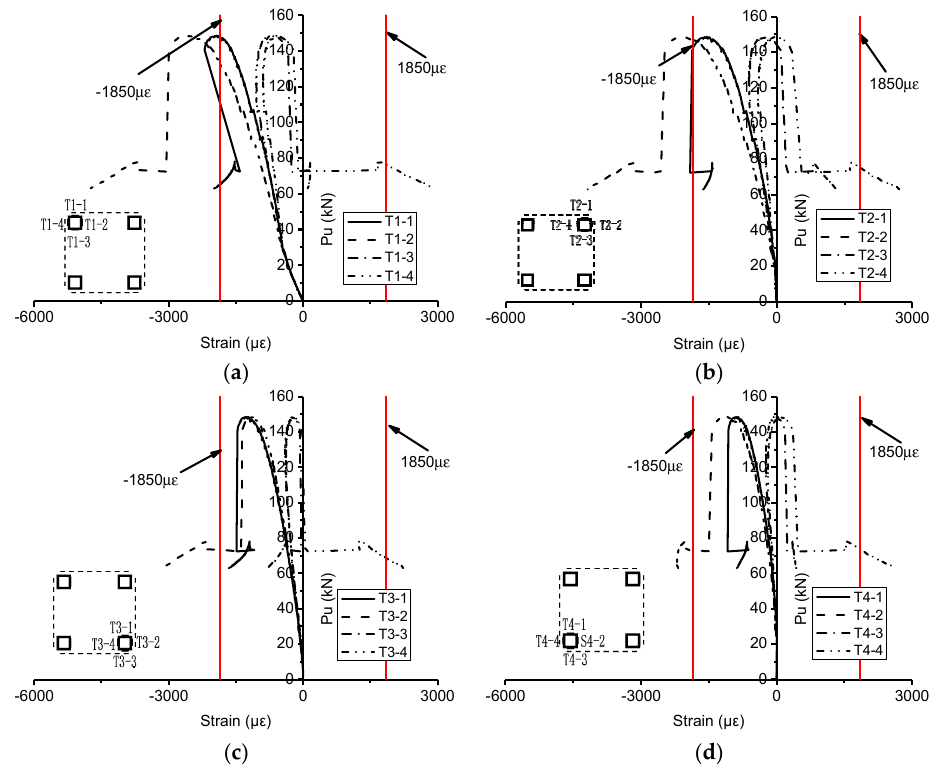
Figure 9. Load-strain curves of tubes of S1: ( a ) T1; ( b ) T2; ( c ) T3; ( d ) T4.